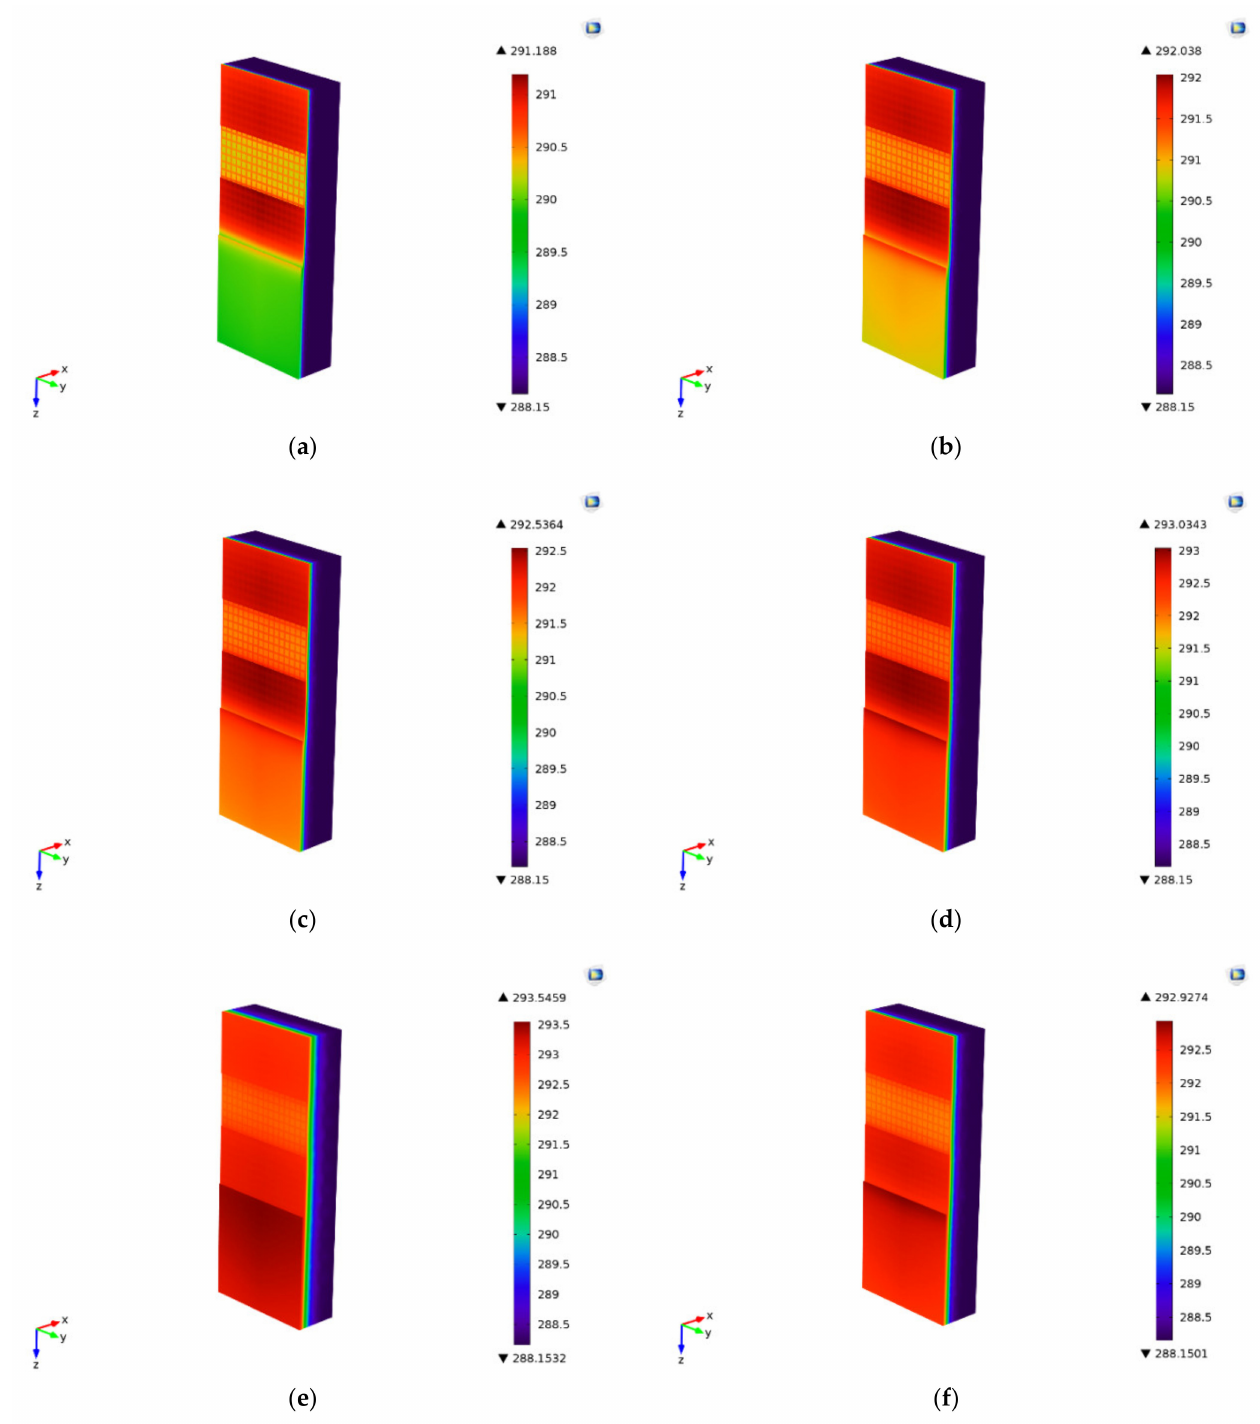
Figure 5. Variations of specimen temperature distribution during the heating phase: ( a ) 10 s of heating, ( b ) 20s, ( c ) 30 s, ( d ) 40 s, ( e ) 50 s, and ( f ) 60